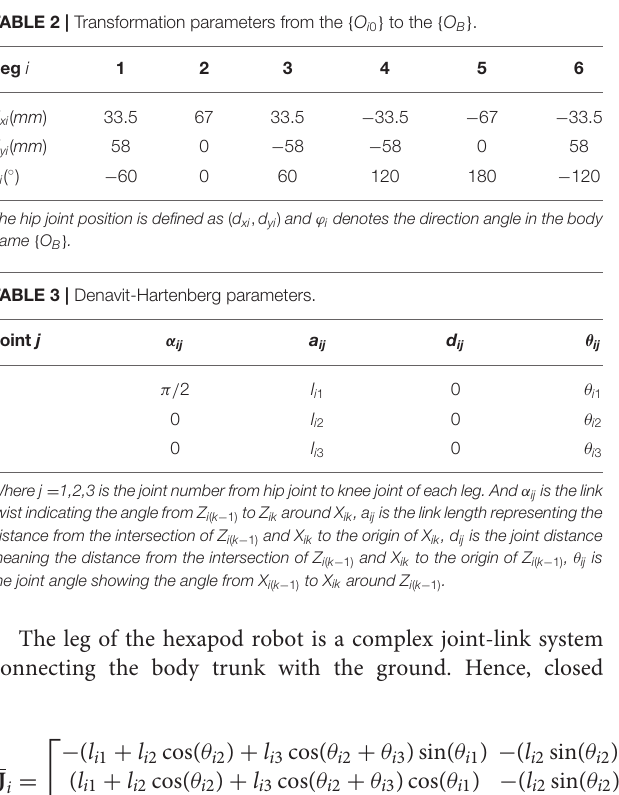
O ik ( k 0,1,2,3) represents the floating frame whose origin fixed { } =